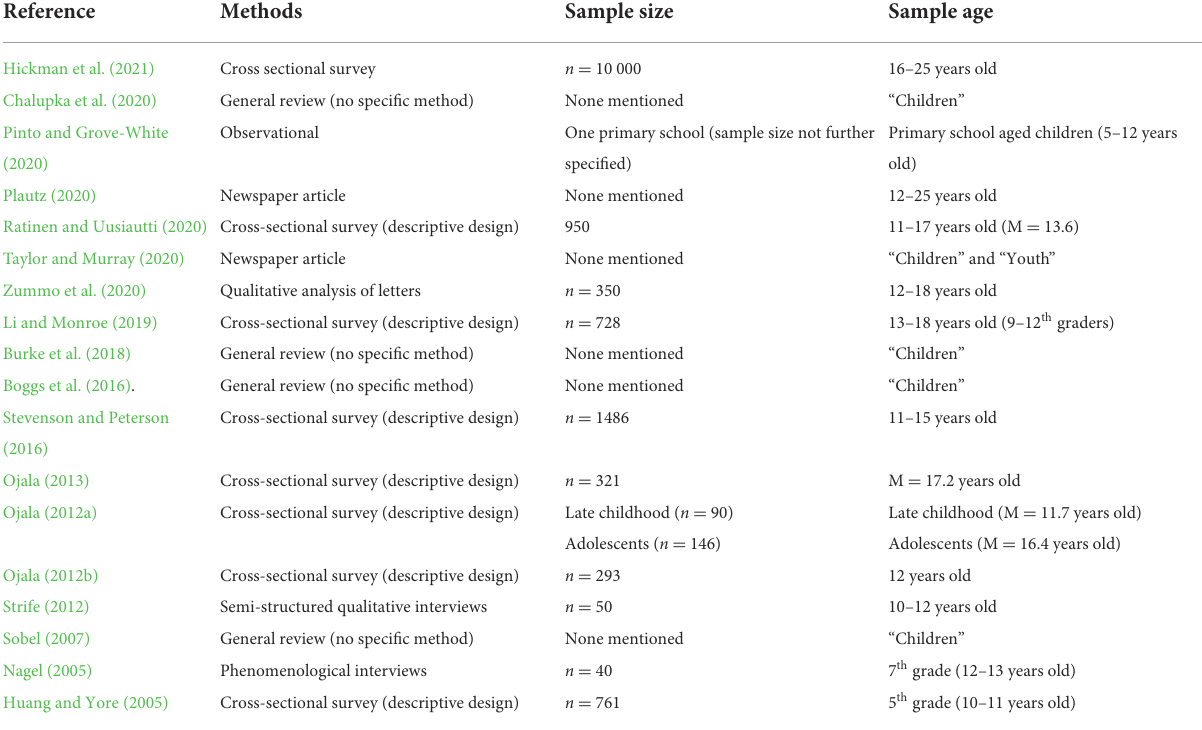
TABLE 2 Methodological information arranged per